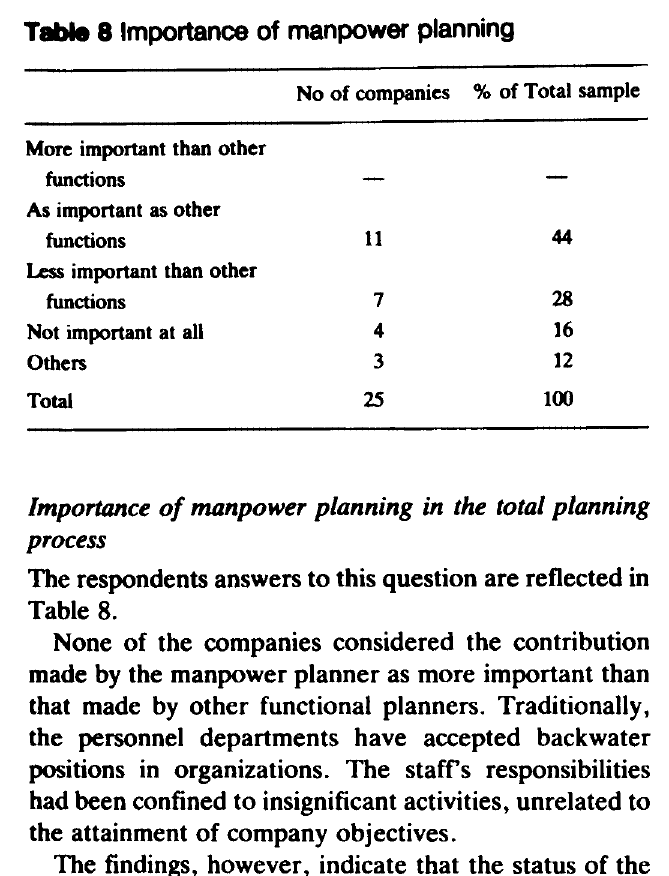
Table 8 Importance of manpower planning Table 9 Communication